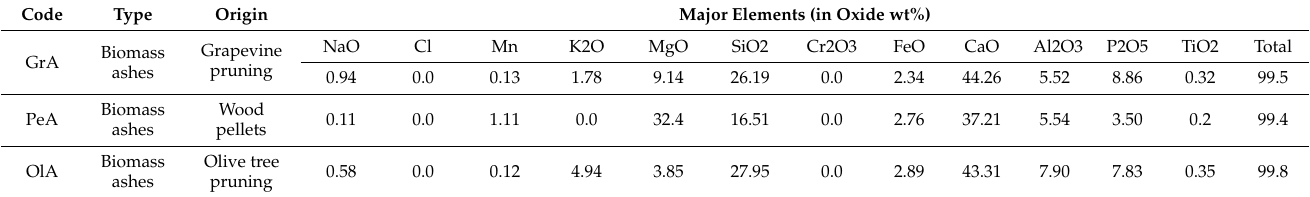
Table 6. Summary of the chemical composition and origin of selected biomass ashes used in this work. Data were taken from Comodi et al. [24].